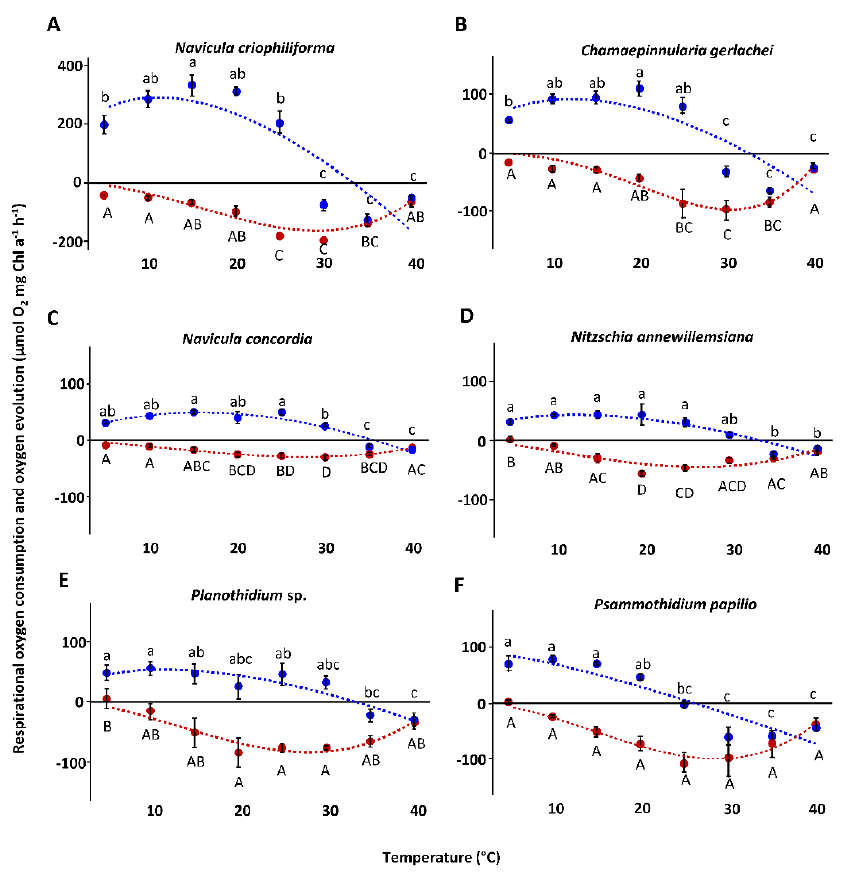
Figure 9. Photosynthetic (blue) oxygen production at 342 ± 40 µ mol photons m − 2 s − 1 and respiratory (red) oxygen consumption in darkness of six benthic diatom strains from Antarctica, as a function of increasing temperature ( A – F ). The measured data were fitted using the model of Yan and Hunt [55] (photosynthesis: blue dashed line; respiration: red dashed line). All cultures were kept in f/2 Baltic Sea media: 33 S A ( A – C ) and 1 S A ( D – F ). Data represent mean values ± SD ( n = 3). Different lowercase (photosynthesis) and capital letters (respiration) indicate significant means ( p < 0.05; one-way ANOVA with post hoc Tukey’s test). ( A ) Navicula criophiliforma , ( B ) Chamaepinnularia gerlachei , ( C ) Navicula concordia , ( D ) Nitzschia annewillemsiana , ( E ) Planothidium sp., and ( F ) Psammothidium papilio